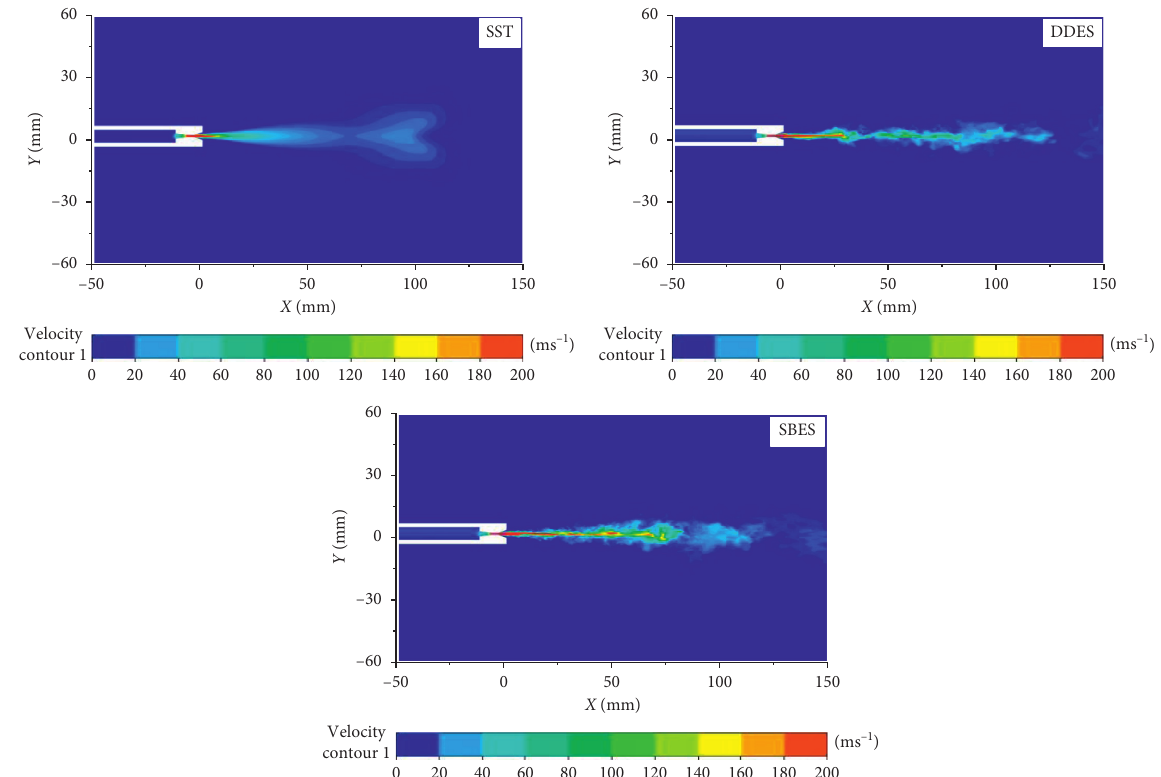
Figure 5: Transient velocity calculated using different turbulence